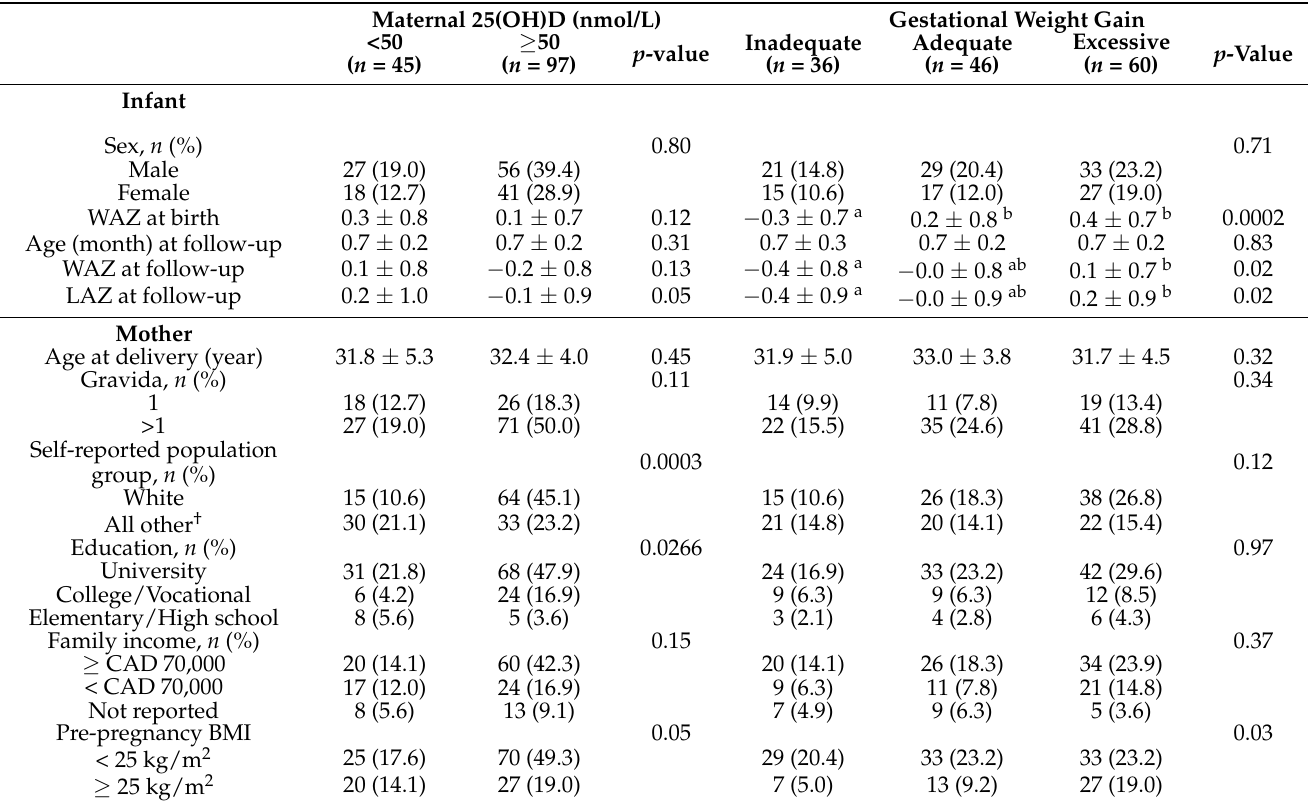
Table 1. Maternal and infant characteristics according to maternal 25(OH)D and gestational weight gain categories.